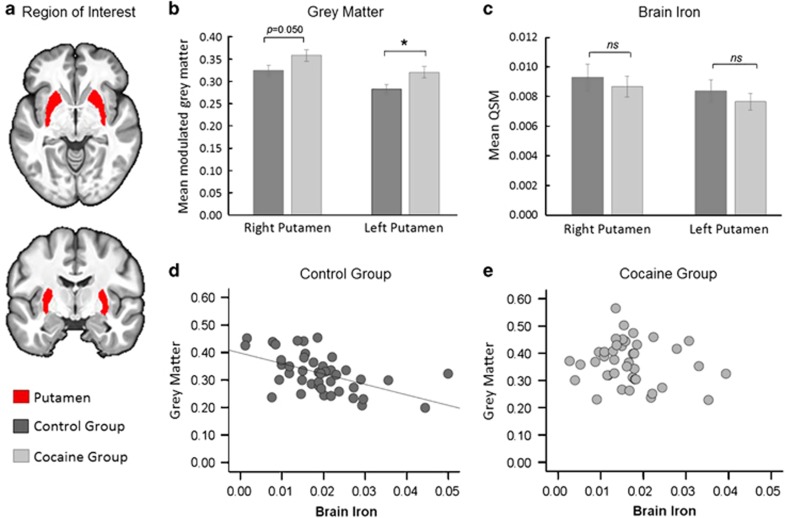
Possible pre-existing abnormalities. (a) Illustration of the putamen, which was our region of interest. (b) Group comparisons of gray matter volume showed a significantly increase in CUD patients compared with controls. (c) Levels of QSM were not measurable different between the groups. (Error bars denote s.e.m., NS indicates P > 0.05 and *P < 0.05). (d) Correlational analysis between gray matter volume (indexed by the mean of the modulated gray matter segment calculated over the FIRST ROI) and brain iron concentration (as indexed by QSM) are inversely correlated in control participants (r=−0.53, P < 0.001). (d) Gray matter volume was unrelated with QSM in CUD (r=−0.13, P=0.416). CUD, cocaine use disorder; QSM, quantitative susceptibility maps; ROI, regions-of-interest.